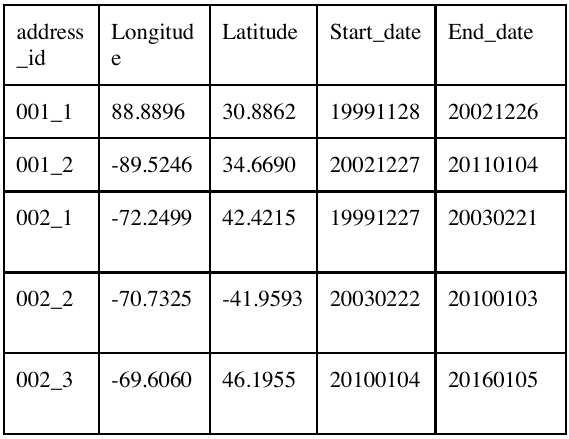
Table 1: Sample (made up) values for input address dataset Longitude, Latitude locations in Table 1 are